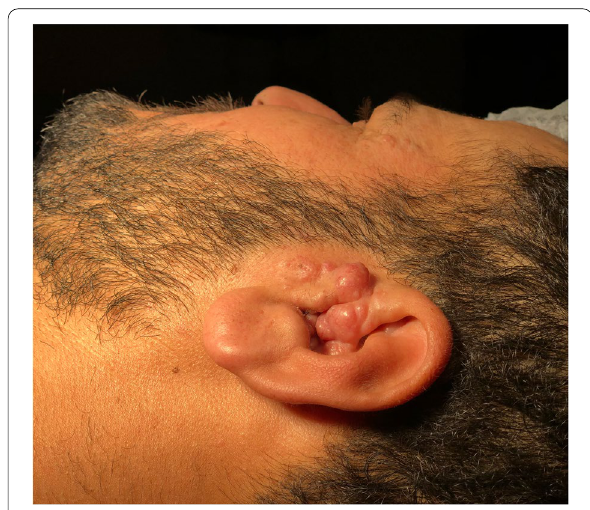
Fig. 2 Total obstruction of external auditory canal due to